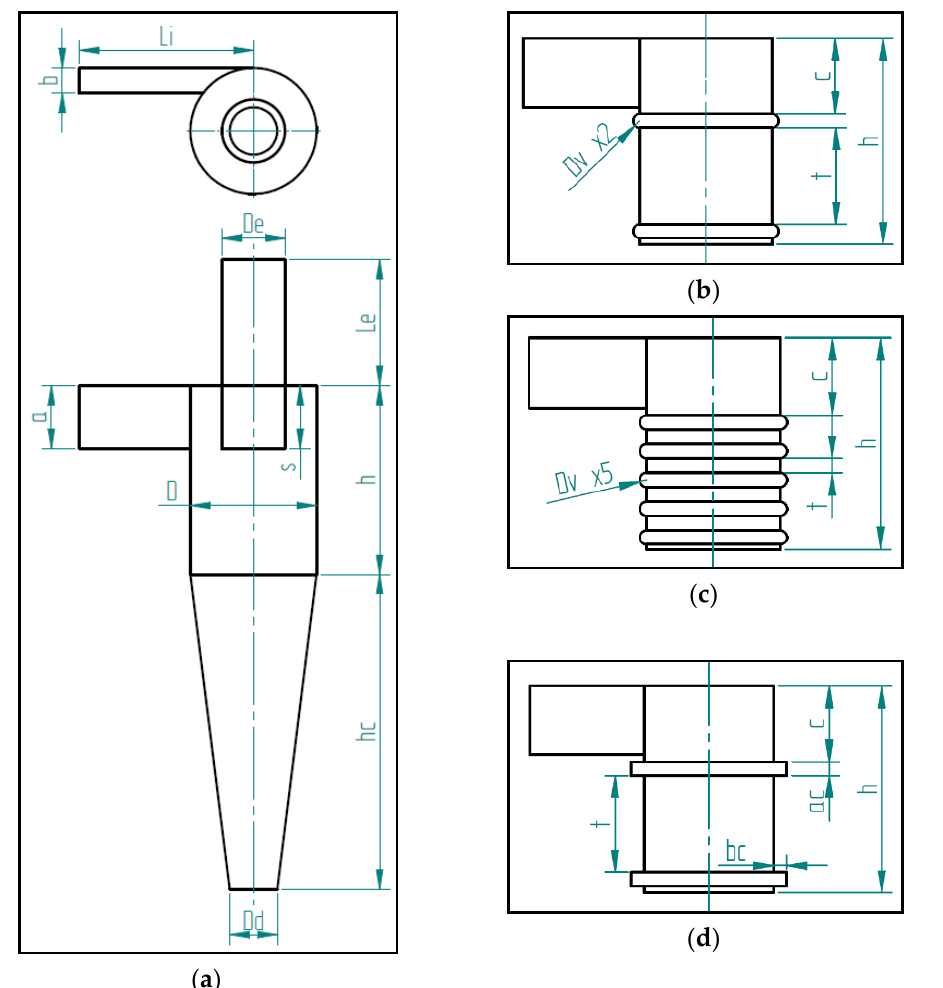
Figure 1 . Schematic diagram of cyclone models; ( a ) Model A (Stairmand cyclone separator), ( b ) Model B cyclone separator, ( c ) Model C cyclone separator, ( d ) Model D cyclone separator.